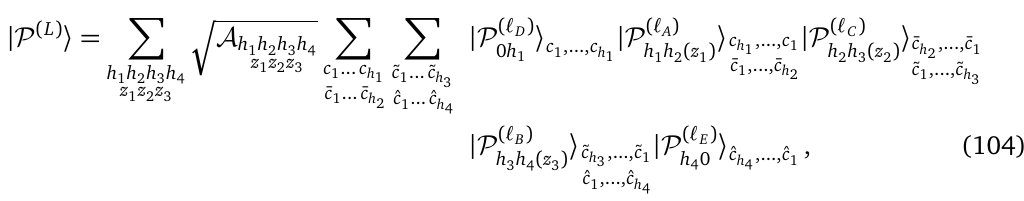
Figure 10: Pentapartition of a spin chain into subsystems A, B, C, D,